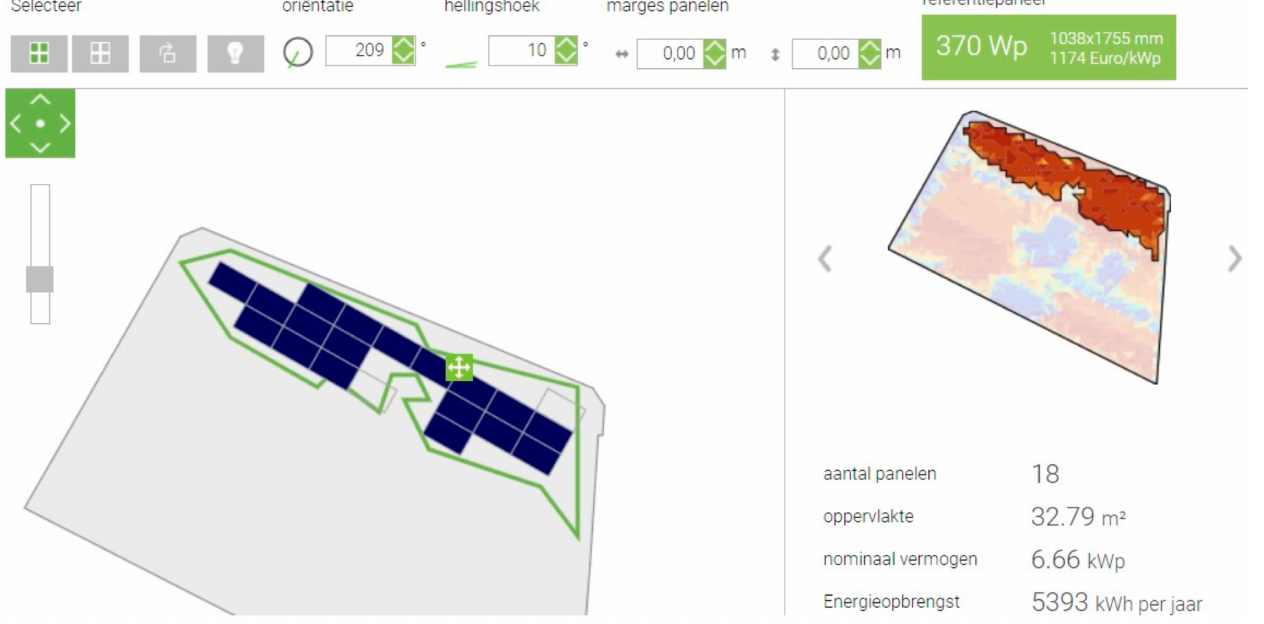
Figure 10. Simulation of individual installation project in Zonatlas Amsterdam. Source: own study based on